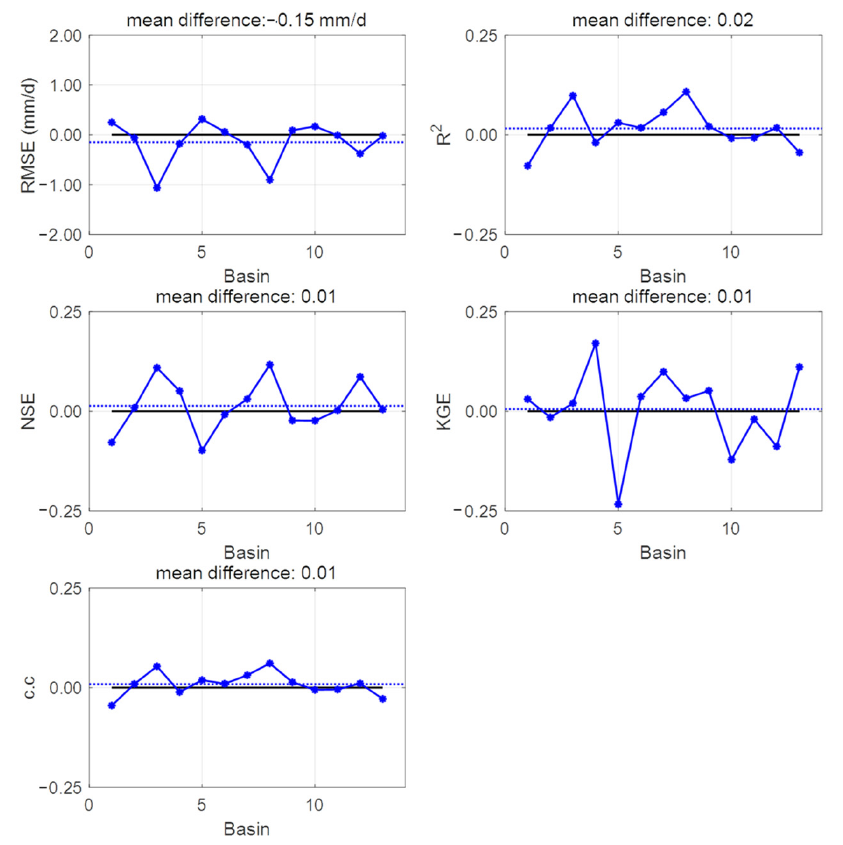
Figure 9. Performance differences between the LSTMs separately learned for each basin (CASE 1) and the LSTM integrally learned for all basins (CASE 2). Note that solid black lines are zero-lines, solid blue lines represent the performance difference (CASE 2 minus CASE 1), and dotted blue lines represent the mean difference.